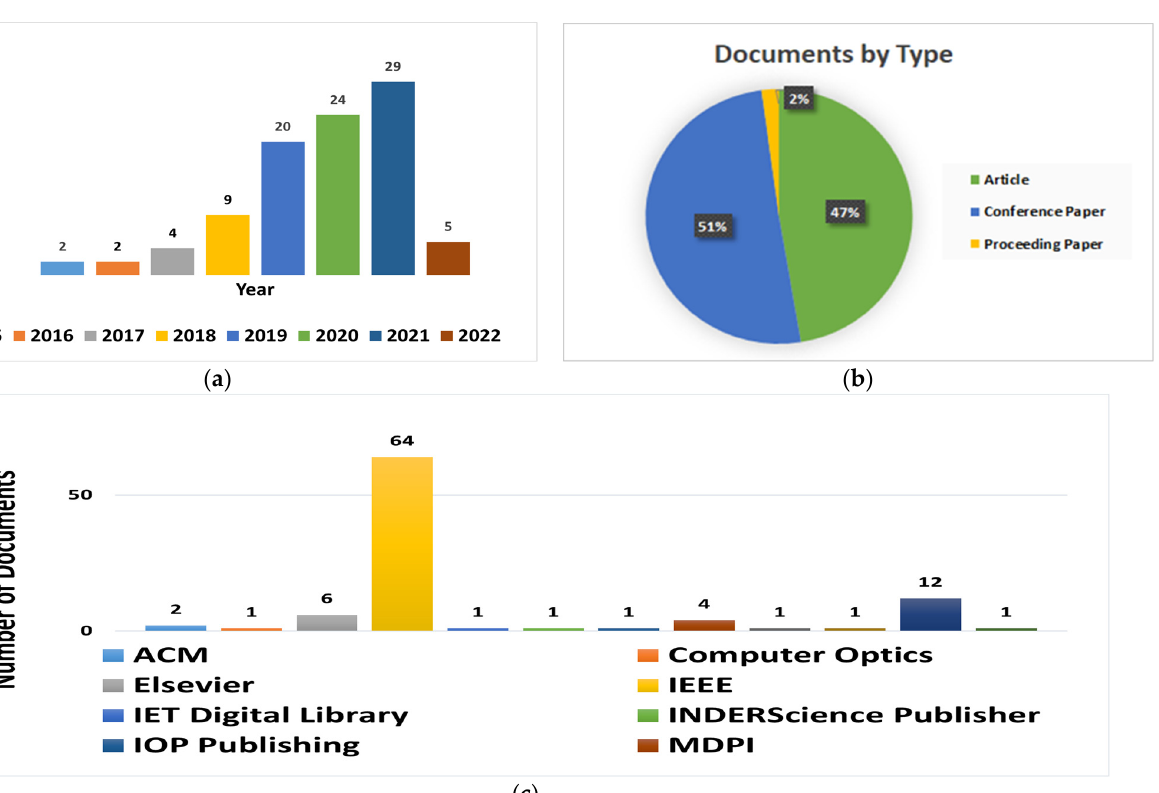
Figure 4. Analysis of selected research articles by ( a ) Publication Year, ( b ) Publication type, and ( c ) Publishing house.